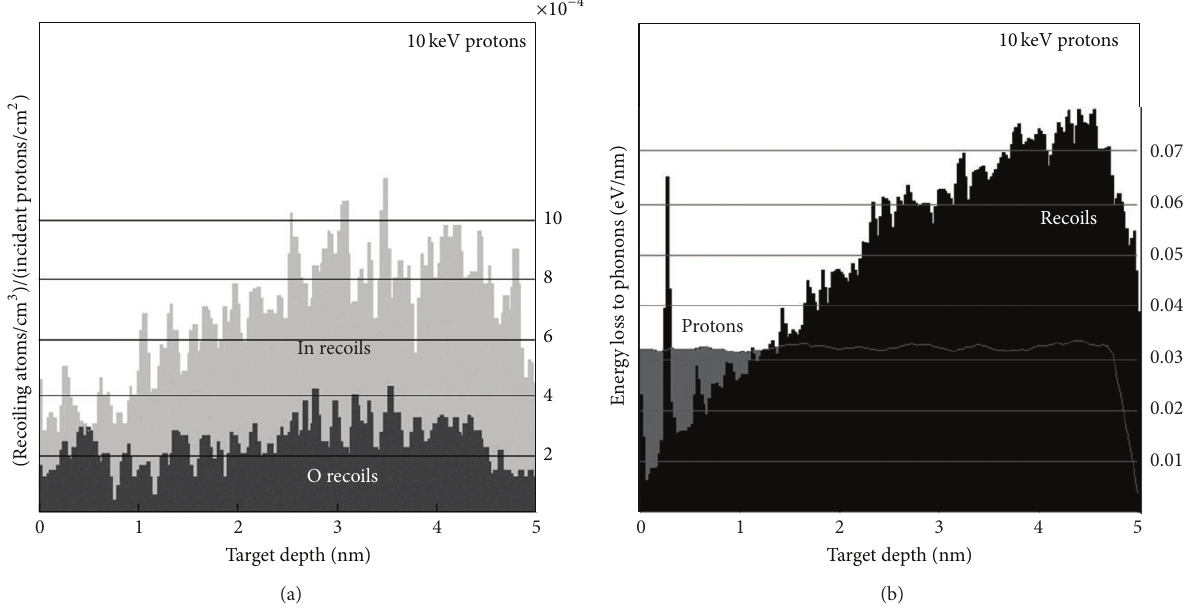
Figure 1: Results of irradiating a 5nm thick InO 𝑥 film by a beam of 10 5 protons with 10keV energy. (a) Distribution of the concentration of the displaced indium and oxygen atoms (recoils) per unit proton fluence. (b) Energy loss to phononic excitations per unit depth by protons and recoils.